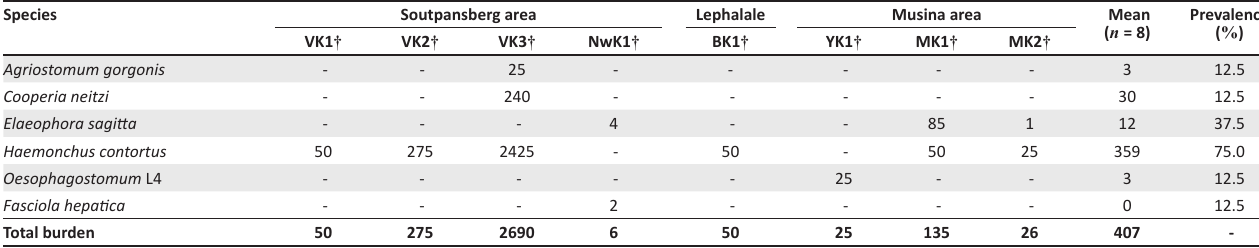
TABLE 3: Total helminth burdens of examined kudu. Species